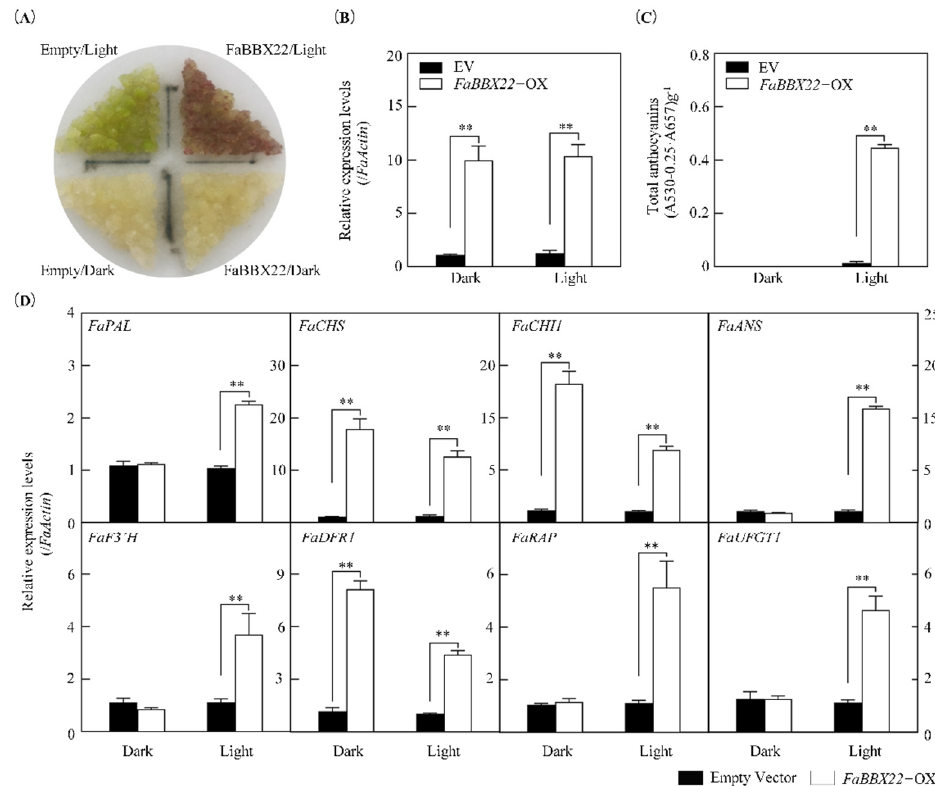
Figure 5. The effects of FaBBX22 overexpression in strawberry calli. ( A ) FaBBX22 ’s overexpression resulted in an anthocyanin accumulation after 7 days of the light treatment; ( B ) FaBBX22 ’s expression level in transgenic strawberry calli; ( C ) Anthocyanins content in transgenic strawberry calli after the light treatment; ( D ) The expression levels of anthocyanin-related genes ( FaPAL , FaCHS , FaCHI1 , FaANS , FaF3 ′ H , FaDFR1 , FaRAP , FaUFGT1 ) in strawberry callis. Error bars represent the SD of three independent replicates. Asterisks indicate significant differences (two − tailed Student’s t − test, ** p < 0.01) compare with empty vector control.